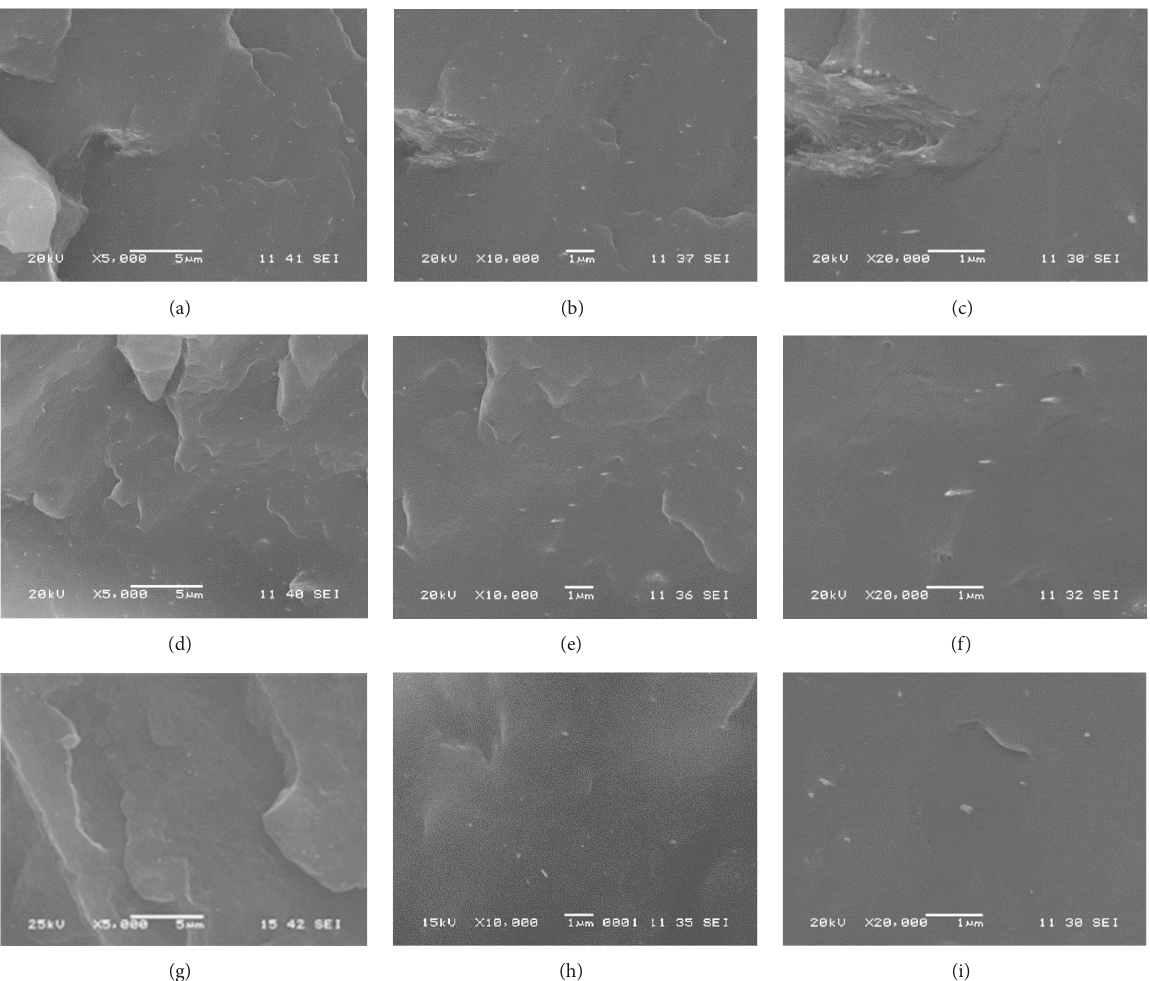
Figure 4: SEM micrographs of the fractured surface at different magnifications of PP/PP-g-MAH/Pal nanocomposites (2 wt.%): Pal-1 (a), (b), and (c); Pal-2 (d), (e), and (f); Pal-3 (g), (h), and